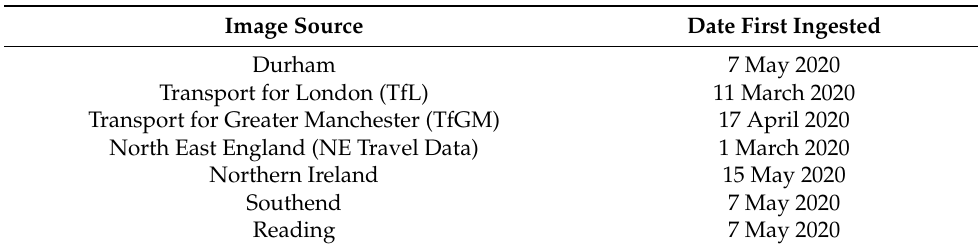
Table 1. Sources of open traffic camera image data used in this research and date when ingestion of data from the source was commenced.